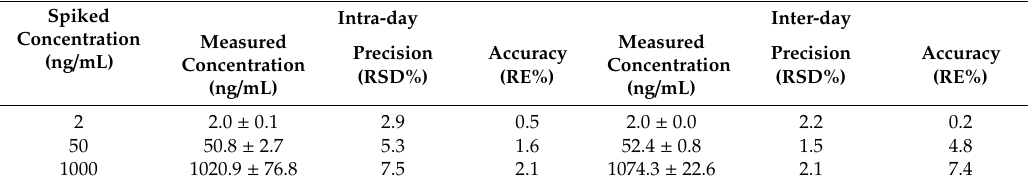
Table 2. The intra- and inter-day precision and accuracy of GC20 in rat plasma (n = 6). Spiked Concentration (ng / mL)